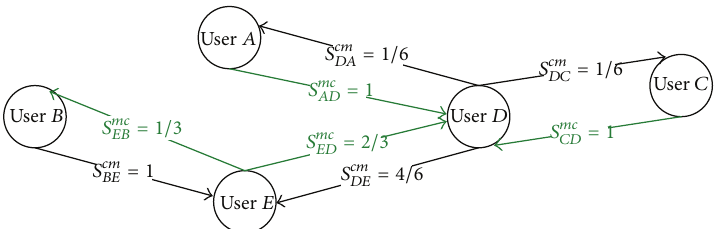
Figure 13: Example of the PTF Is Commentator and MF Is Moderator layer of the final SN extracted from the flat presocial network FPSN (Figure 12).